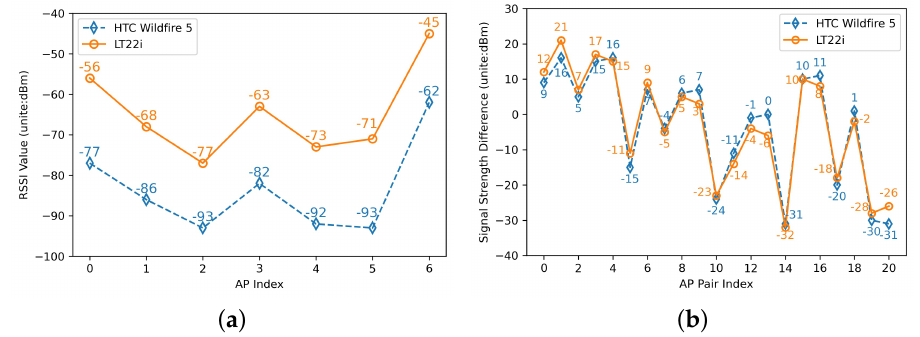
Figure 6. DIFF Calibration-free Processing. ( a ) Signal strength detected by HTC Wildfire 5 and LT22i smartphones at a fixed location. ( b ) Extract signal strength difference from